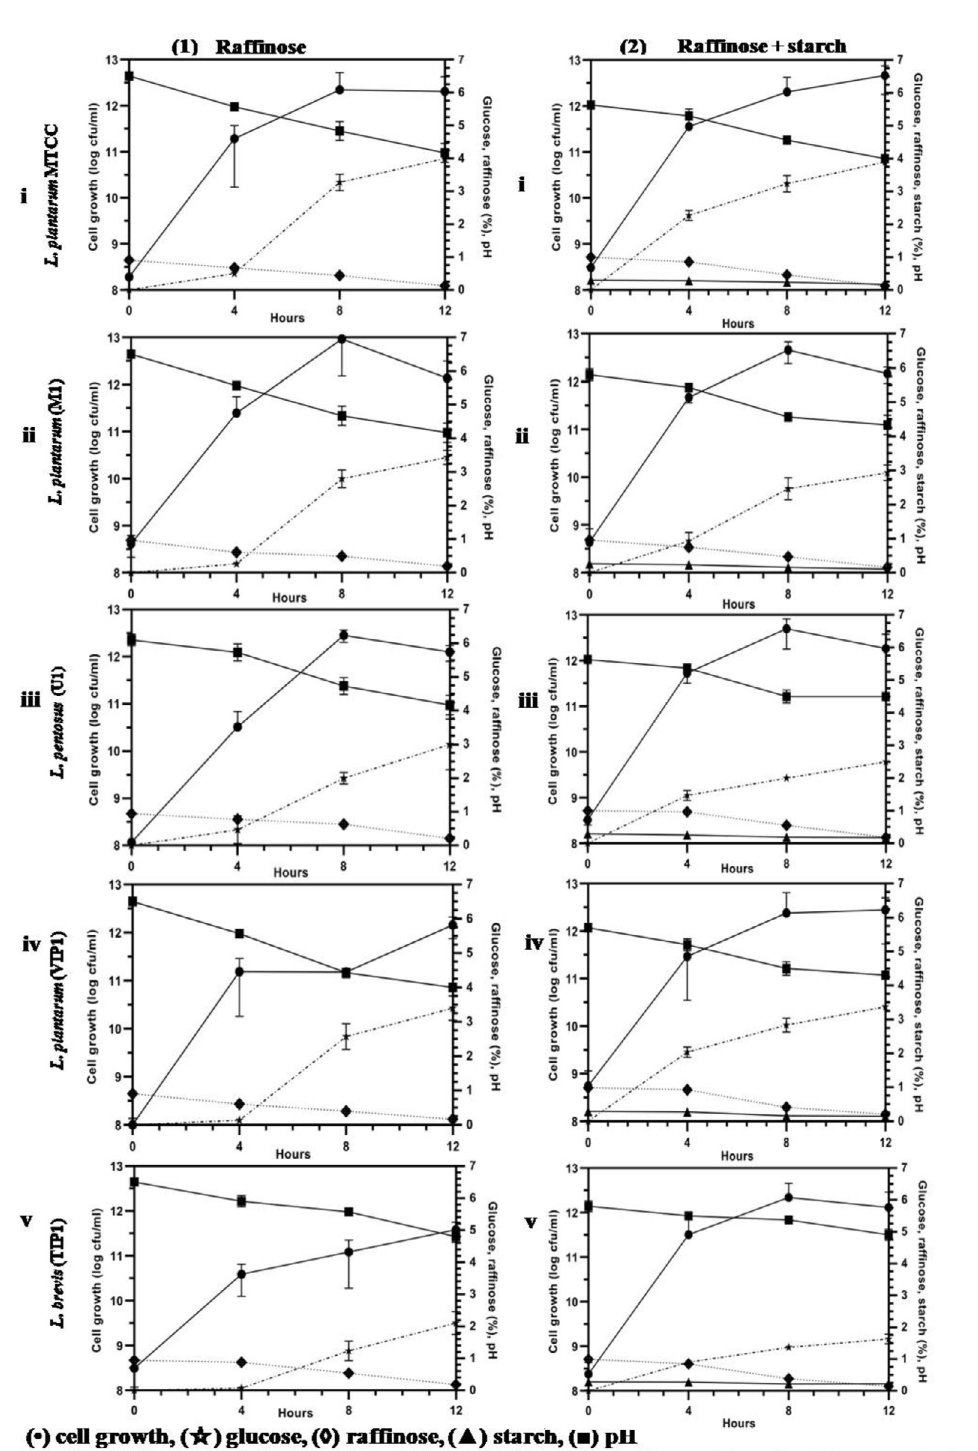
Fig. 2B. (Kinetics of different carbohydrate utilization using raffinose (1), and raffinose + starch (2), during fermentation with Lactobacillus isolates and reference strain in mMRS